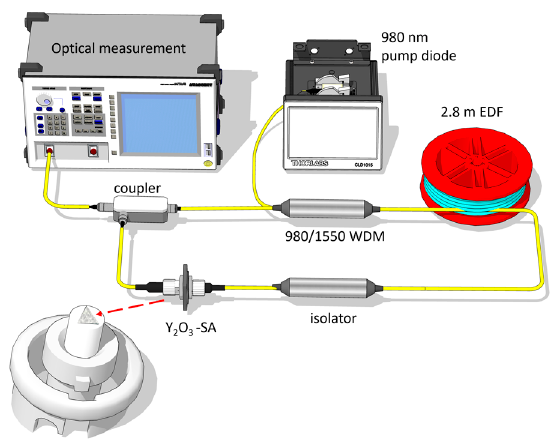
Figure 3. The configuration of the mode-locked Erbium-doped Fiber Laser (EDFL) utilizing Y 2 O 3 - PVA